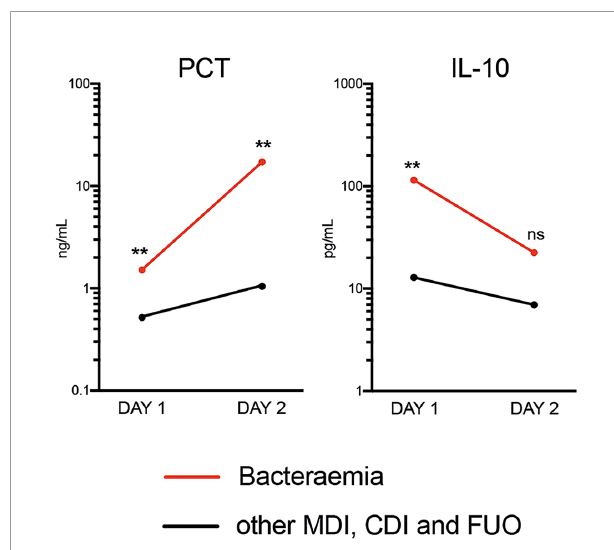
FIGURE 2 | Mean Plasma PCT and IL-10 levels between time of FN presentation (Day 1) and Day 2 when comparing bacteraemia cases with all other causes of FN. P-values shown were calculated using ROC analysis comparing bacteraemia cases with non-bacteraemia cases at Days 1 and 2. Data shown as Mean and SEM. **p <0.005, ns p >0.05 (not signi fi